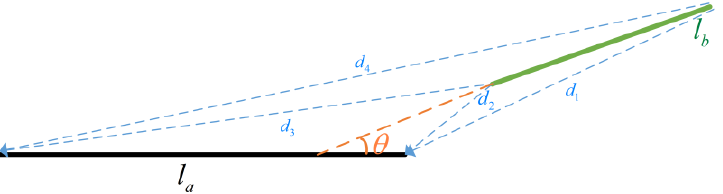
Figure 6. Schematic diagram of the angle difference between segments and the distance between endpoints.